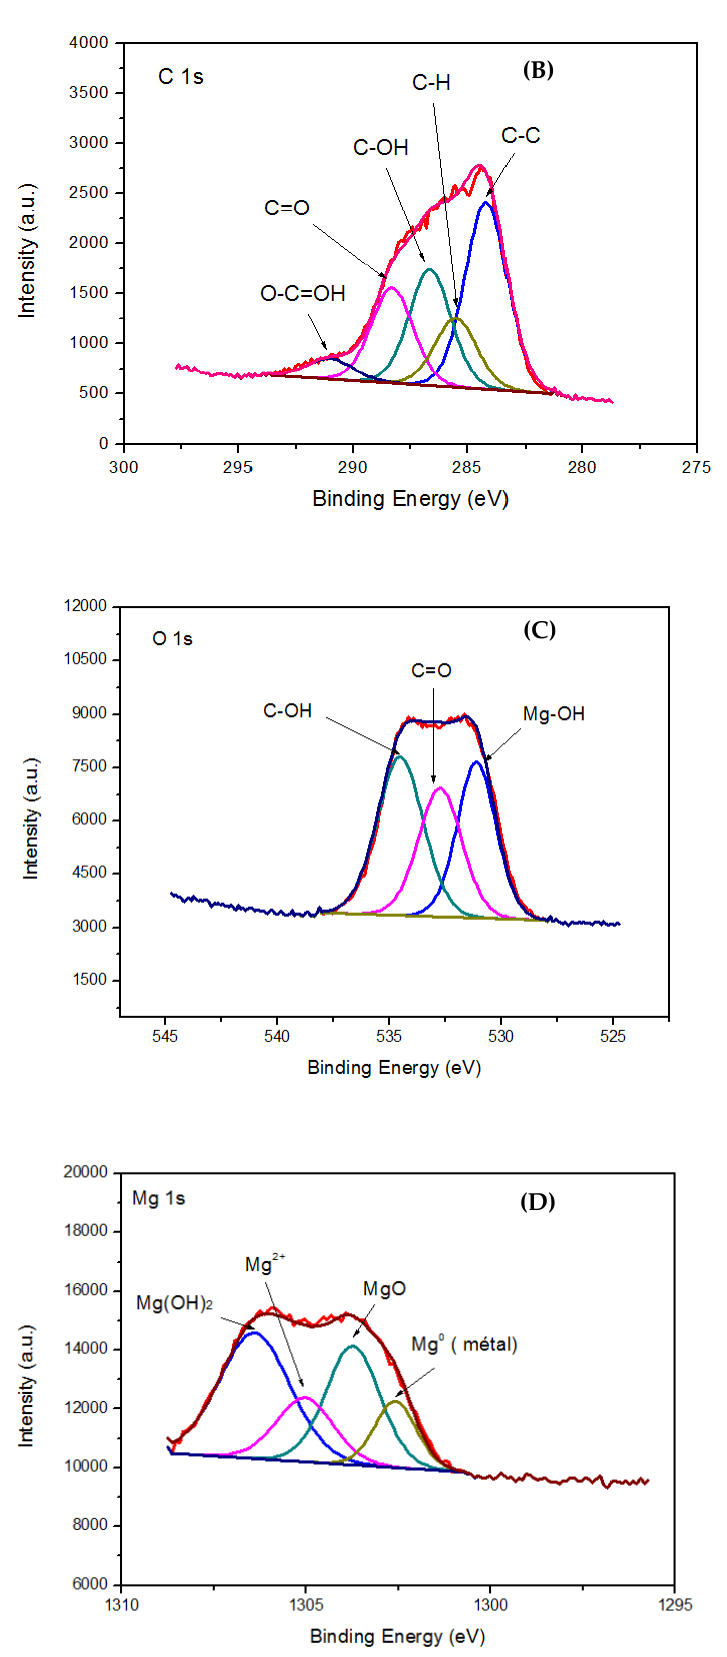
Figure 3. XPS Spectra of MgO–rGO1:2 nanocomposite. Survey spectrum ( A ), C 1s ( B ), O 1s ( C ) and Mg 1s ( D ) high-resolution